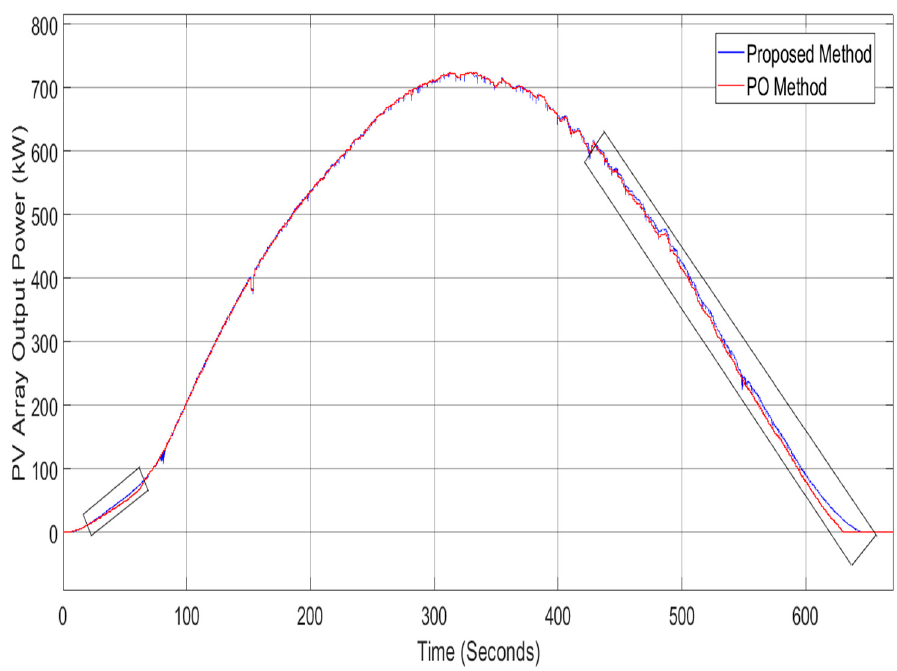
Figure 6. Output power of the proposed method and the PO method on a clear day.